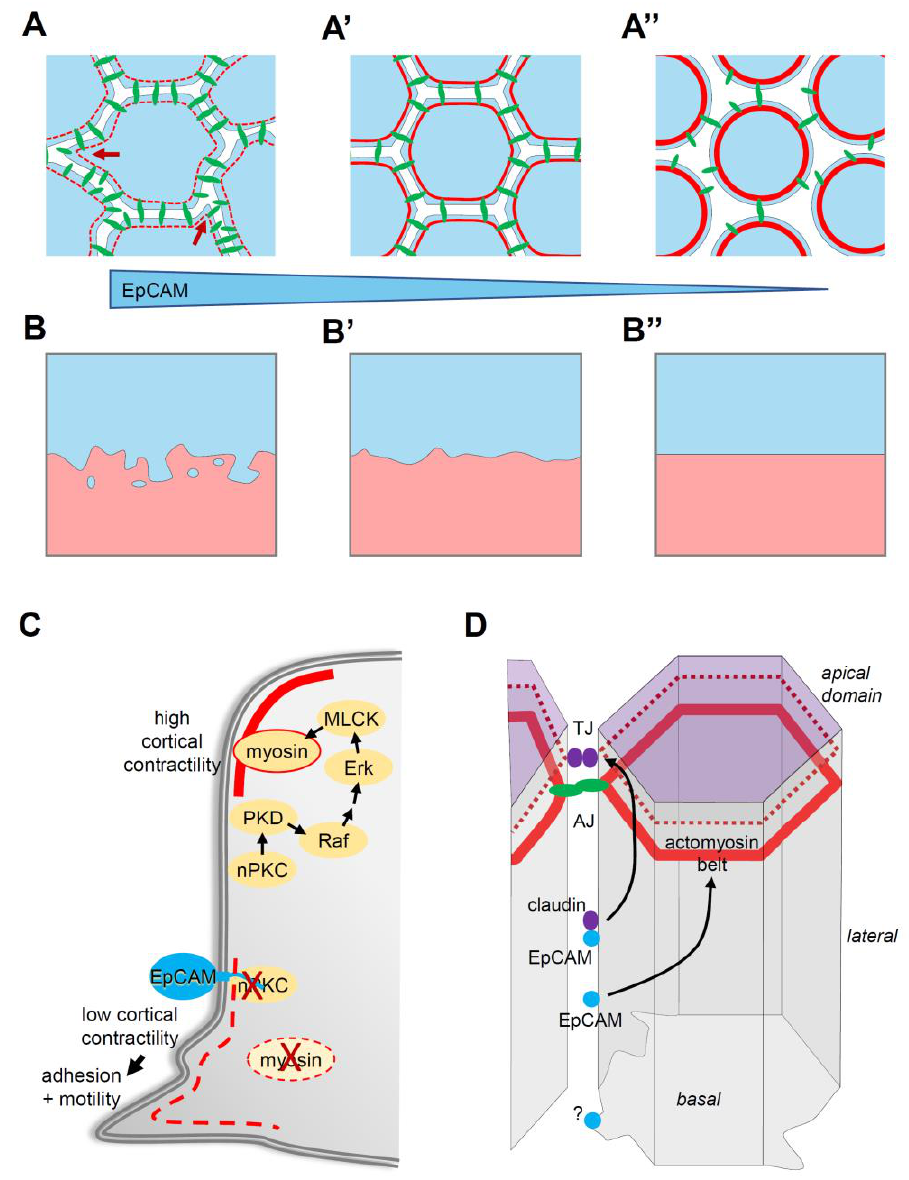
Figure 2. EpCAM, tissue plasticity and integrity. ( A , A’ ) EpCAM levels regulate cell motility and adhesion: An increase in EpCAM levels (transition from ( A’ ) to ( A )) promotes intercellular migration by repressing actomyosin cortical contractility (from red continuous lines to dashed thin lines), which stimulates both protrusive activity (dark red arrows) and dynamic cell–cell adhesion (cadherins in green). ( A” ) Loss of EpCAM can lead to uncontrolled cortical contractility (thick red line), resulting in a strong decrease in or even loss of cell–cell adhesion. ( B , B’ , B” ) EpCAM levels impact on tissue plasticity: The blue and pink surfaces represent two cell populations. At moderate levels ( B’ ), intercellular migration is limited, and the two populations remain coherent. A high levels ( B ), cells actively migrate within the tissue and even between tissues, adopting an “invasive” behaviour, explaining in particular the embryonic tissue mixing phenotype. Low EpCAM-expressing cells ( B” ) fail altogether to migrate, due to impaired motility and adhesion. ( C ) Molecular mechanism responsible for control of myosin contractility. nPKCs activate one of the pathways that stimulates myosin activity and promotes high cortical contractility. This pathway involves the phosphorylation of PKD, a direct target of nPKCs, which triggers the Raf–Erk cascade. Erk can in turn activate myosin light chain kinase (MLCK). EpCAM cytoplasmic tail binds and inhibits nPKCs. This results in decreased myosin activity and cortical contractility, allowing protrusive activity and promoting cell